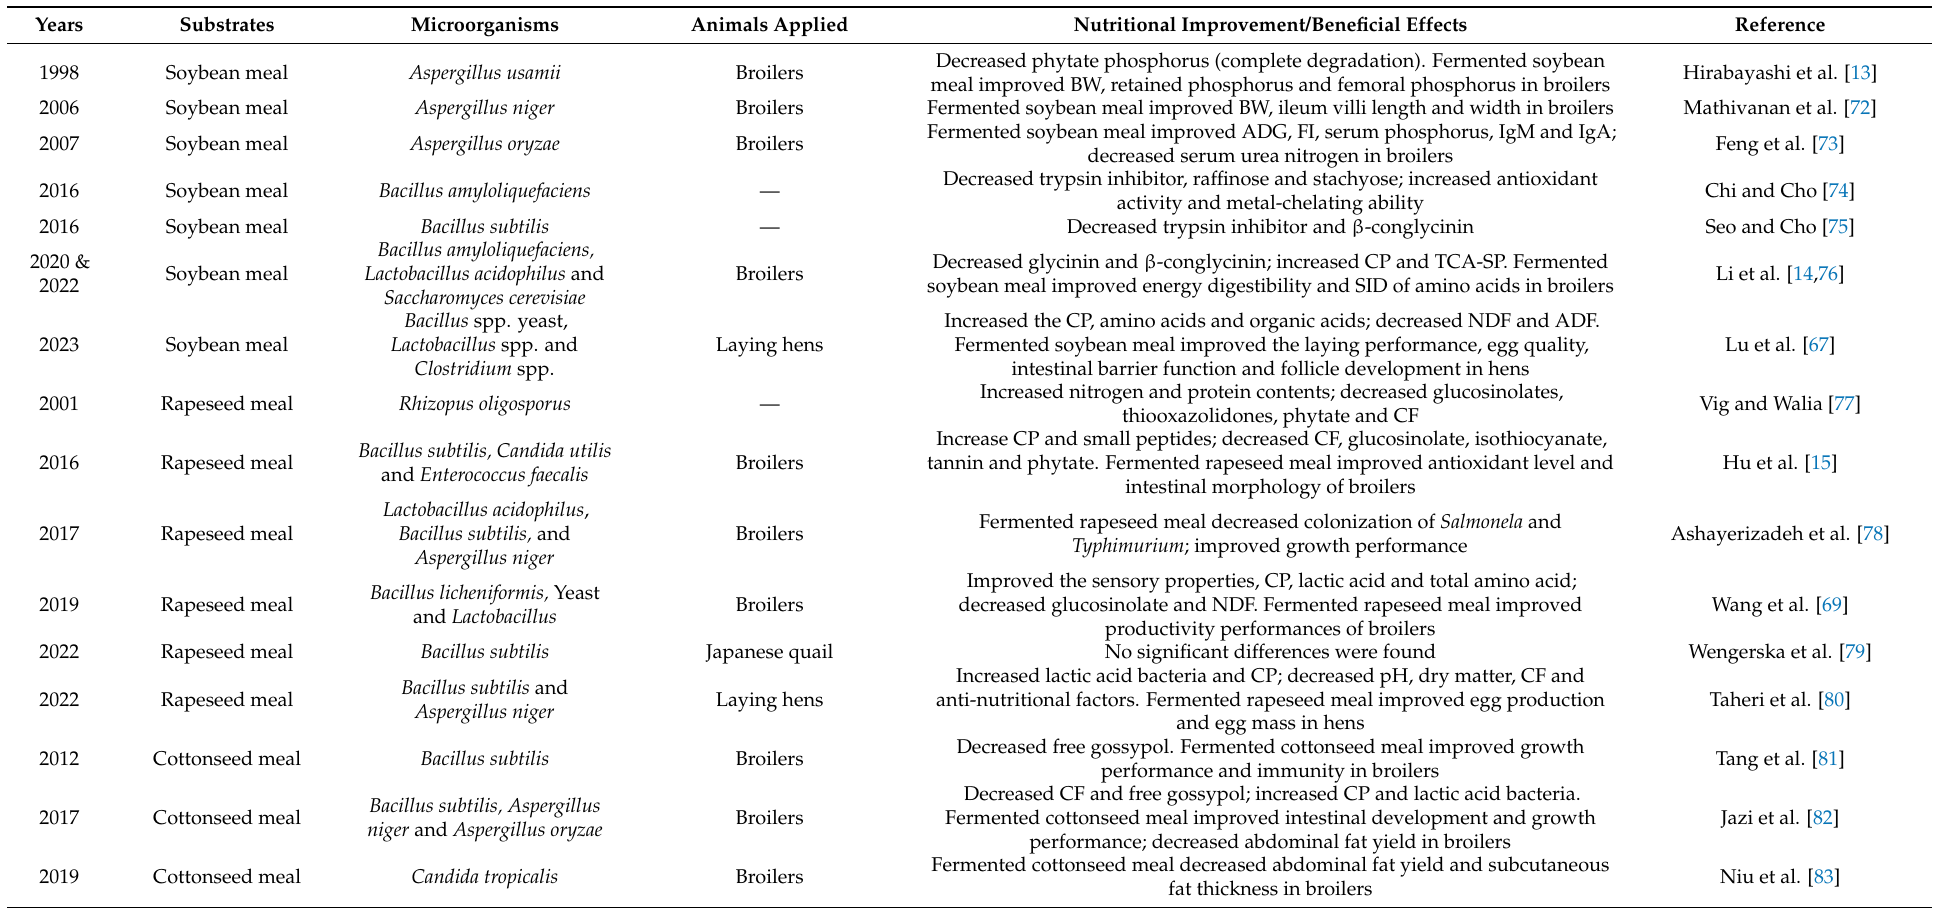
Table 3. The nutritional changes of common plant protein sources during fermentation and their application effects in